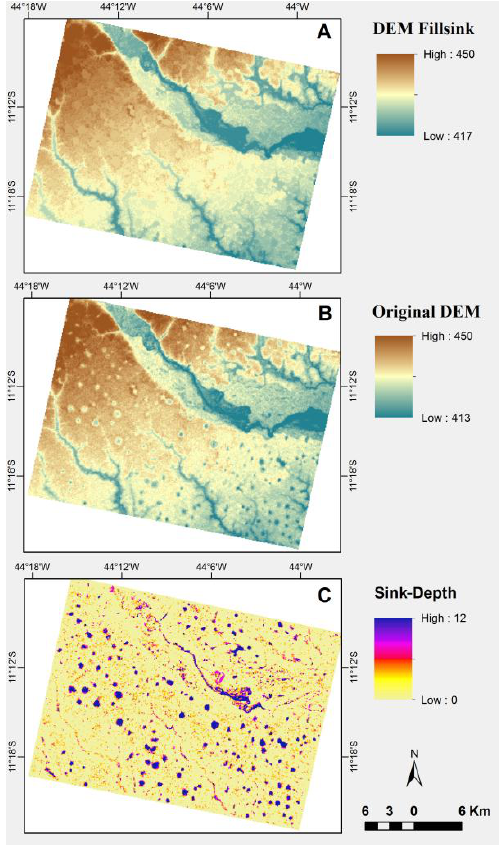
Figure 3. Methodological procedures to determine the terrain attribute of sink depth. ( C ) sink-depth